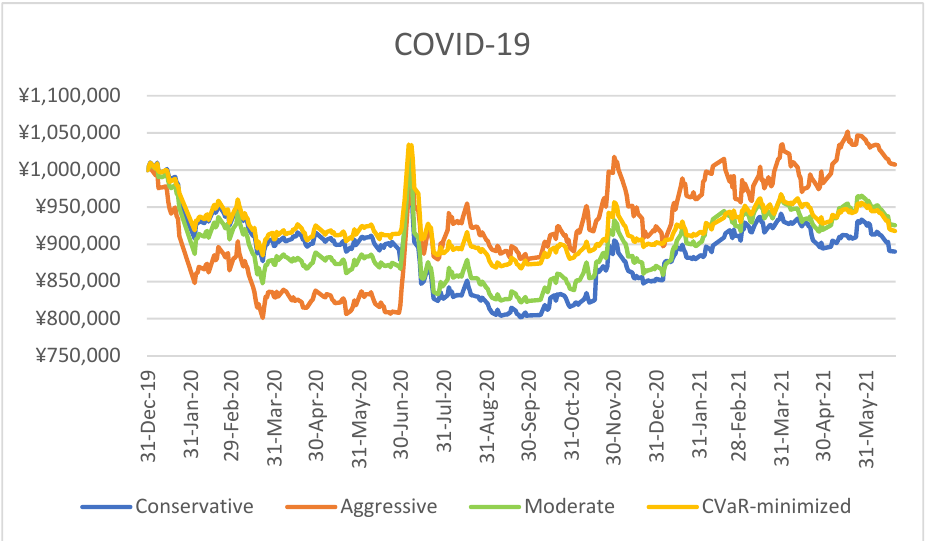
Figure 4. Cumulative gains from four investment strategies in the post-GFC period.